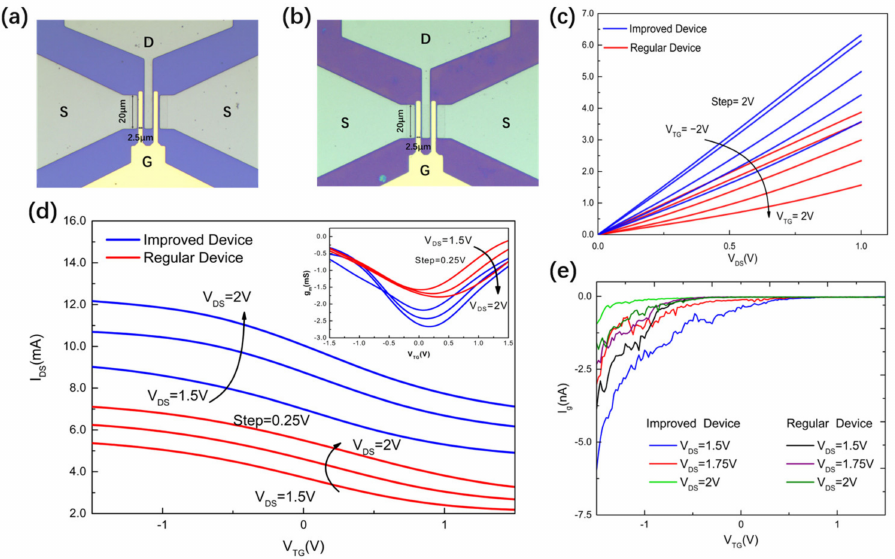
Figure 6. Optical images of top-gate graphene transistors: ( a ) the improved device; ( b ) the regular device. ( c ) The output characteristics of top-gate graphene transistors fabricated by the improved (blue line) and regular (red line) processes, respectively. The drain voltage ( V DS ) scans from 0 V to 1 V and the top-gate voltage ( V G ) sweeps from − 2 V to 2 V. ( d ) The comparison of transfer characteristic curves of improved device (blue line) and regular device (red line) at different V DS of 1.5 V, 1.75 V, and 2 V. Inset: the corresponding transconductance ( g m ) as a function of gate voltage ( V TG ). ( e ) The top-gate leakage current ( I GS ) as a function of V TG for the improved device and the regular device at different V DS of 1.5 V, 1.75 V, and 2